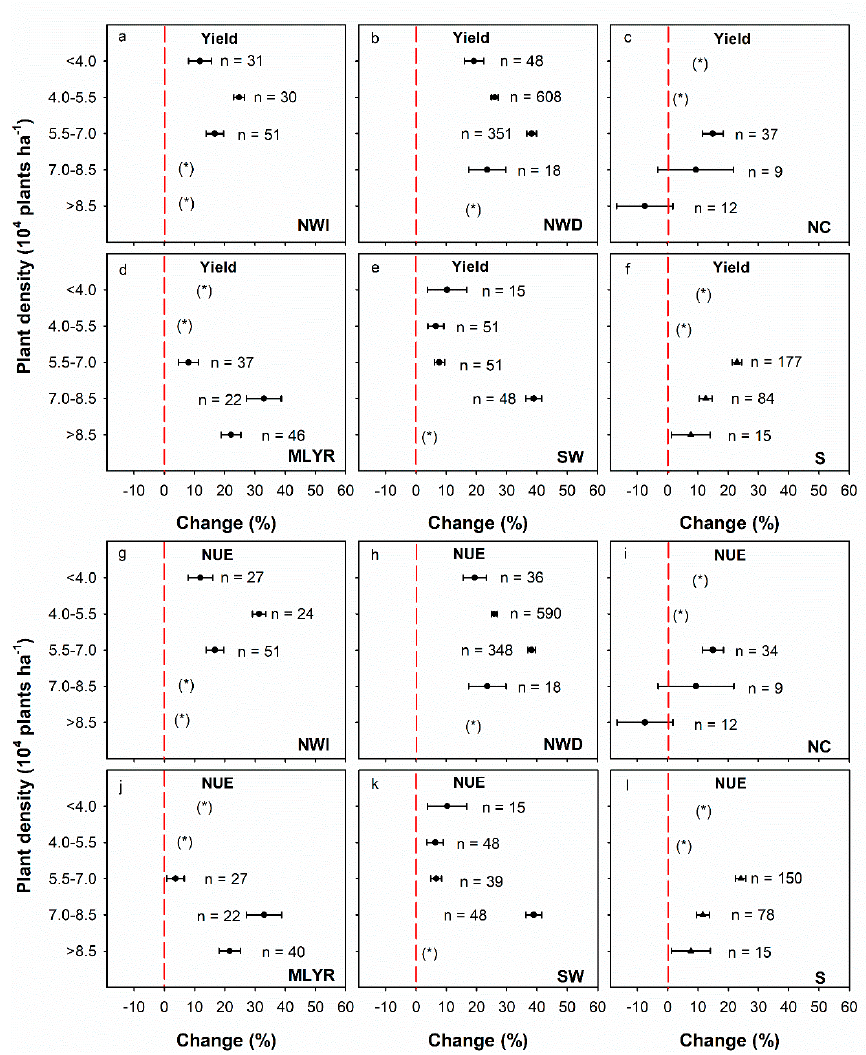
Figure 5. Response of change in potato yield ( a – f ) and NUE ( g − l ) to mulching compared to no mulching at different levels of plant density in different regions of China. The values for n represent the corresponding number of observations. Asterisks (*) represent fewer than two valid comparisons for a subgroup. NC, North–Central China; QT, Qinghai and Tibet; NE, Northeast China; NWI, Northwest irrigation region; NWD, Northwest dryland region; MLYR, the middle and lower reaches of the Yangtze River; SW, Southwest China; and S, South China. Error bars represent 95% confidence intervals.